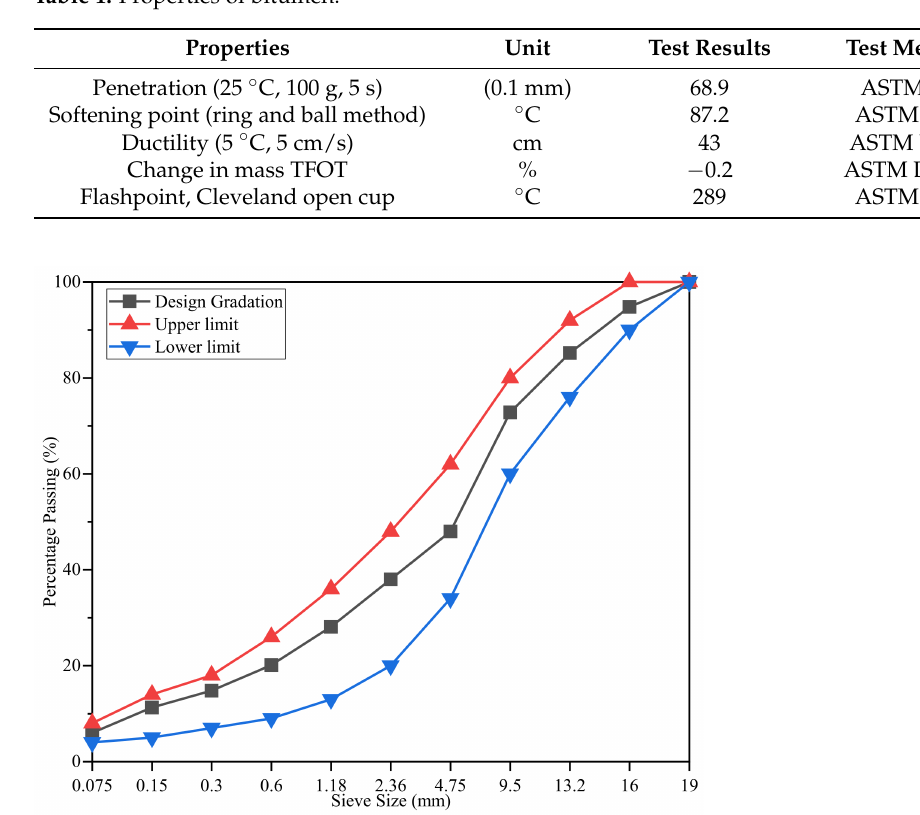
Table 1. Properties of bitumen.